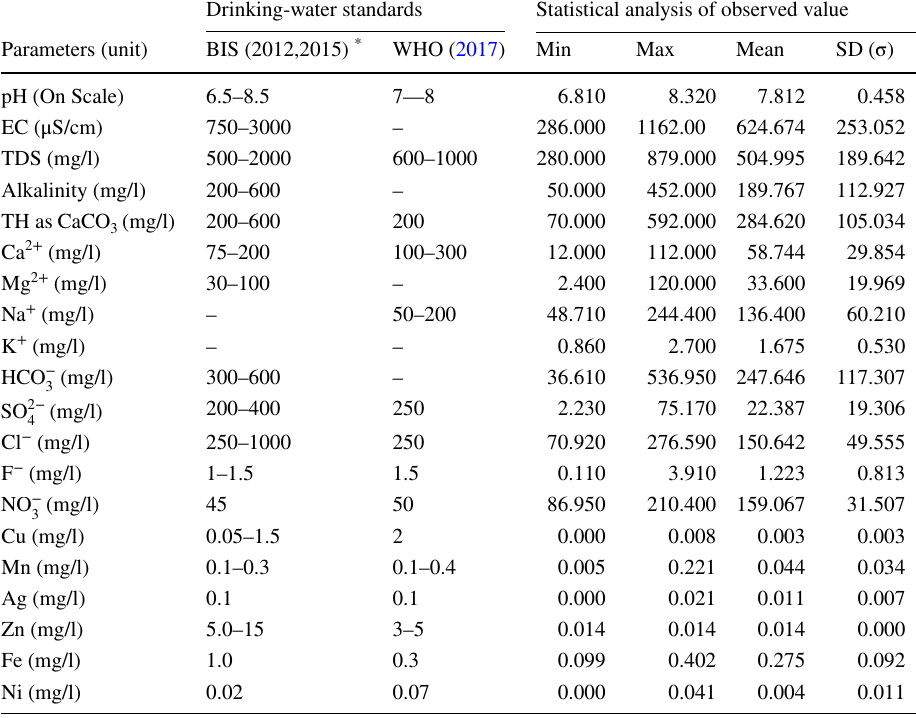
Table 1 Statistical analysis of groundwater quality parameters and its coherence with BIS and WHO